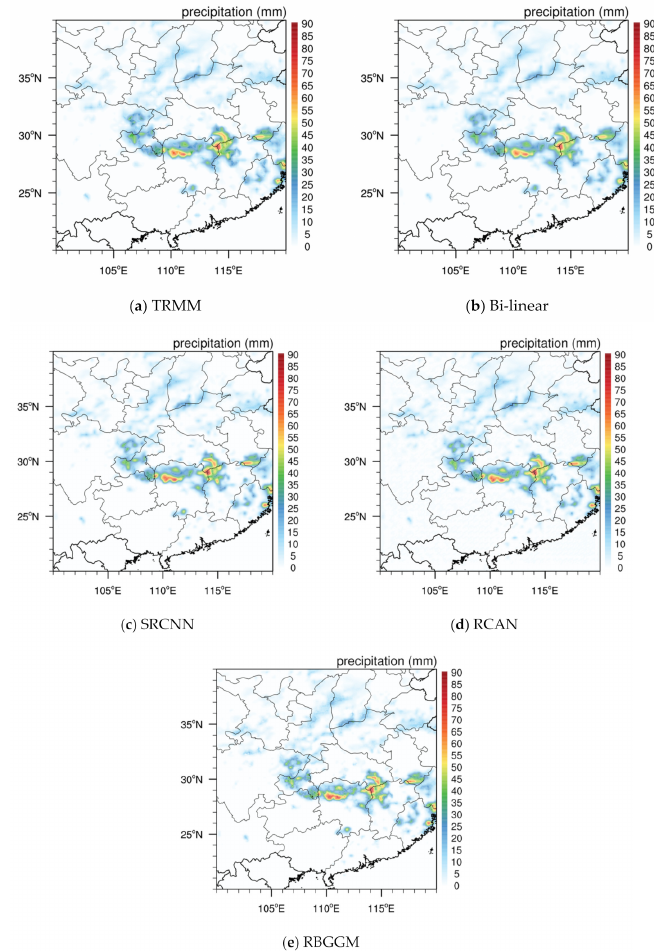
Figure 11. The distribution of TRMM precipitation: ( a ) TRMM; as well as precipitation downscaling results: ( b ) bi-linear; ( c ) SRCNN; ( d ) RCAN; and ( e )